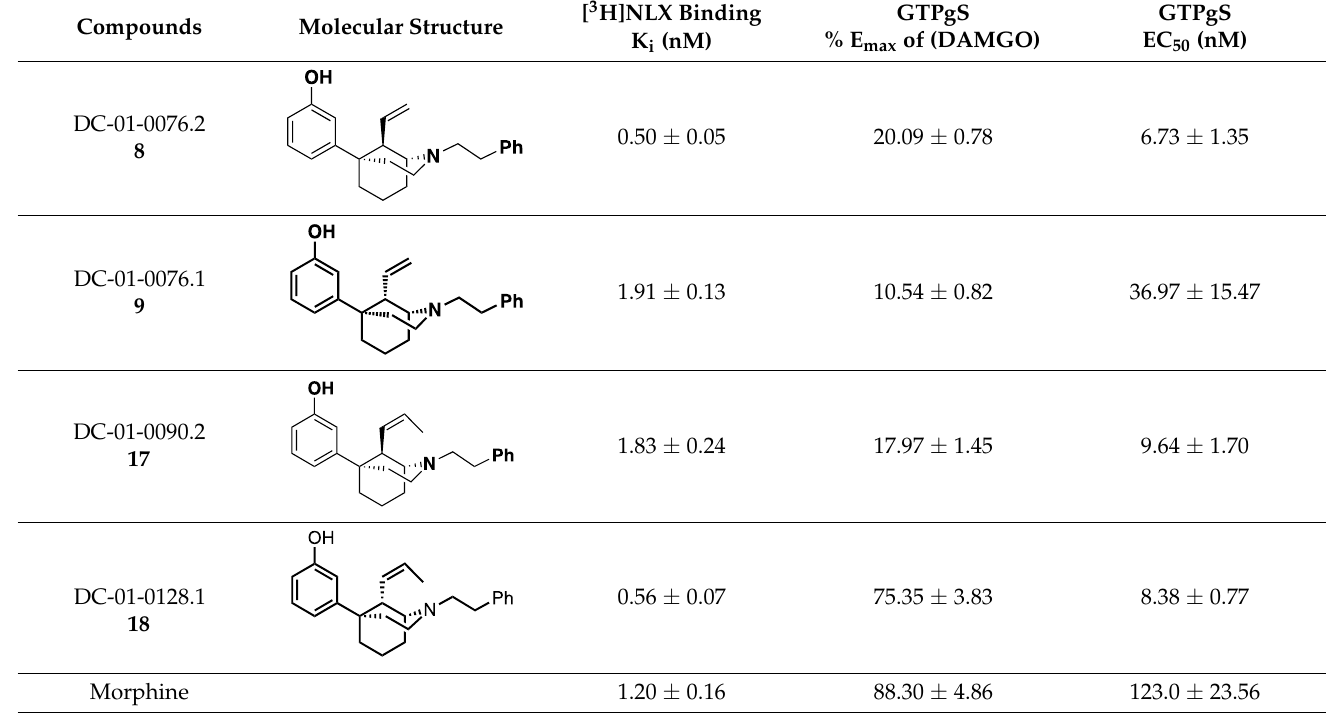
Table 3. MOR radioligand binding assay (K i , nM) and MOR [ 35 S]GTPgS functional assay a .